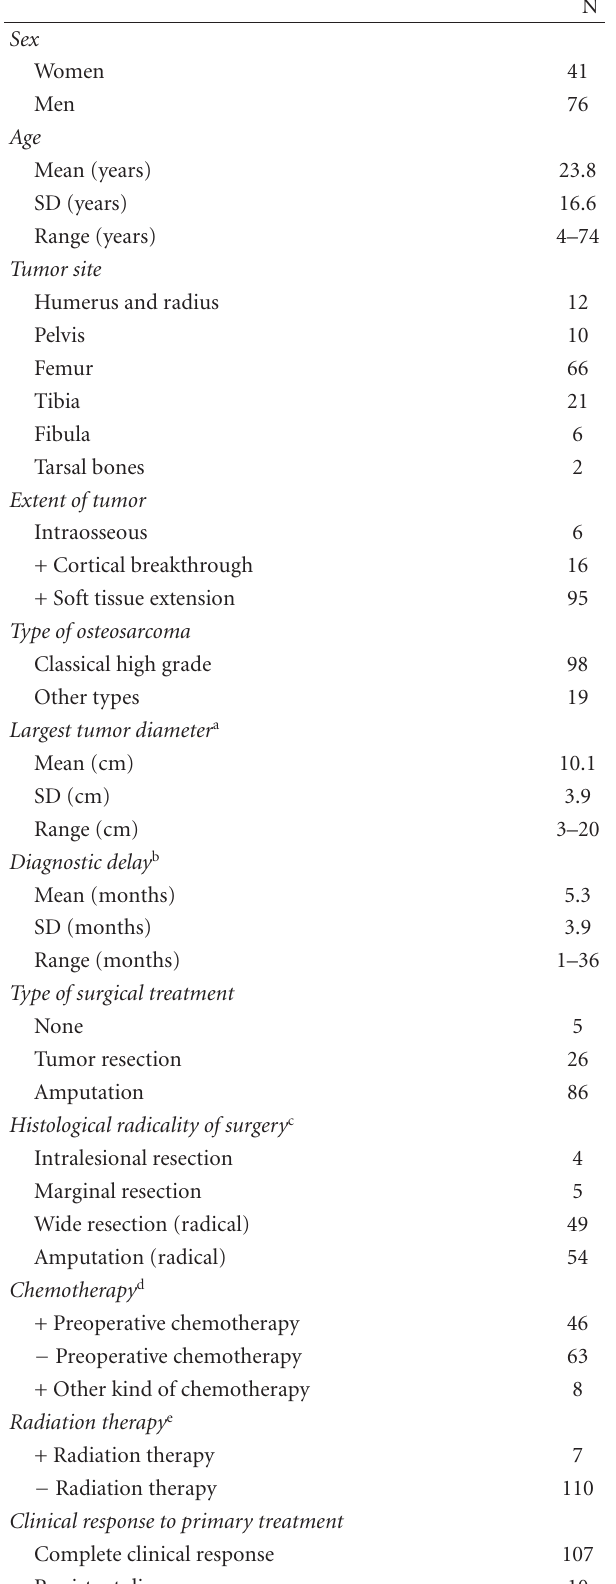
Table 1: Clinicopathological data of 117 patients with primary